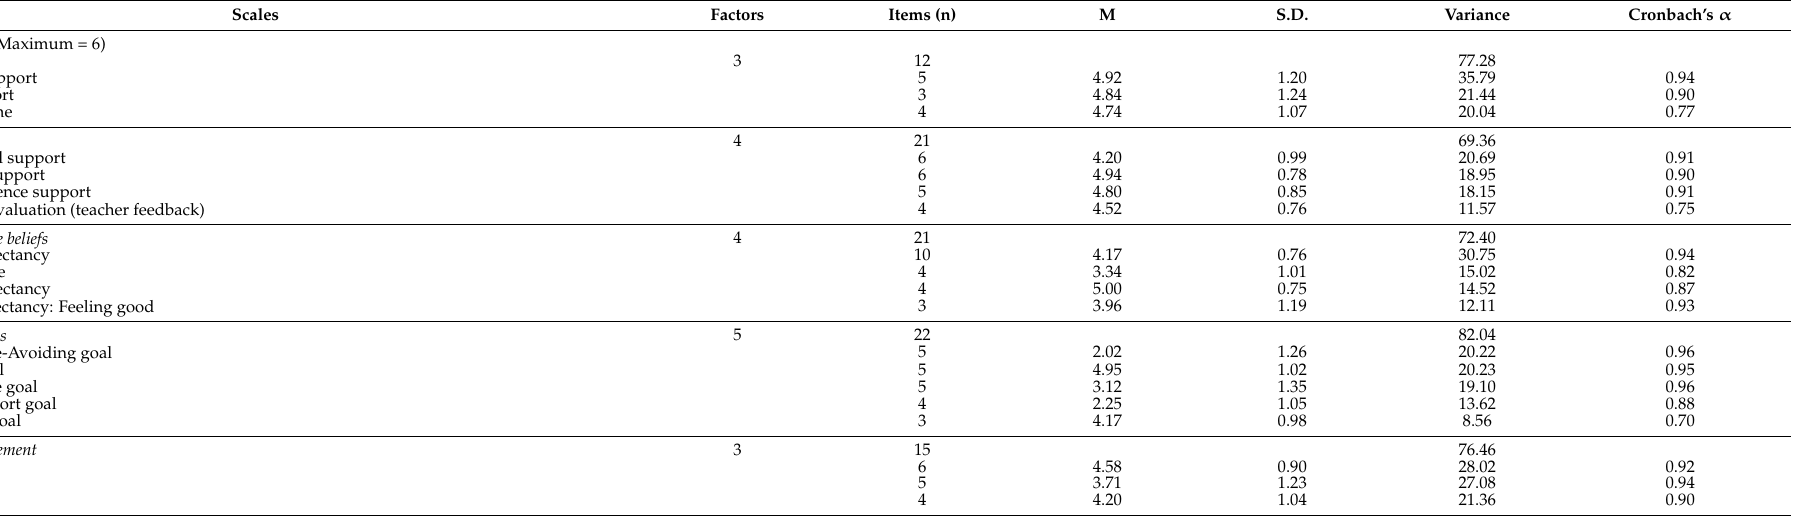
Table 1. Summary of the exploratory factor analysis and internal consistency of